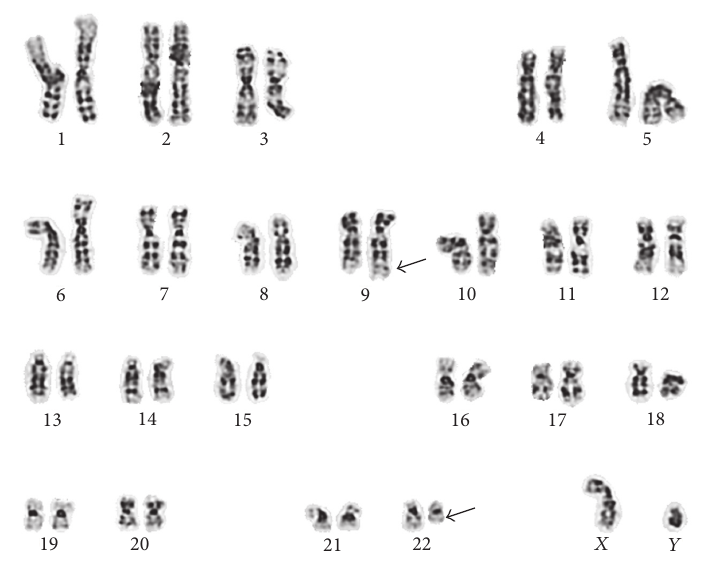
Figure 1: G-banded metaphase cell with 9/22 translocation (arrows indicate derivative chromosome 9 and 22 products).